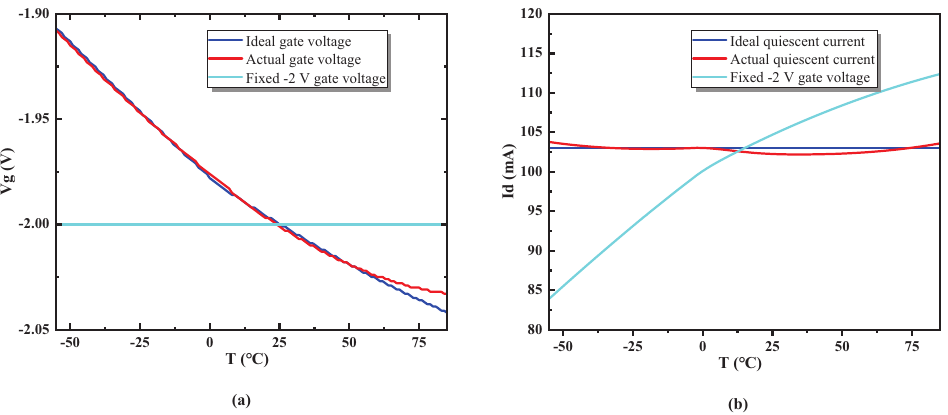
Figure 7. Simulation results of the temperature compensation bias circuit. ( a ) Temperature compen- sation circuit output voltage. ( b ) Quiescent current of the drive